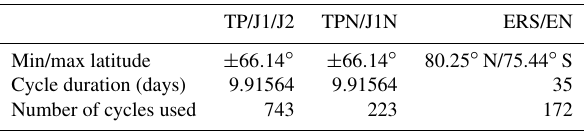
Table 3. Description of altimeter data